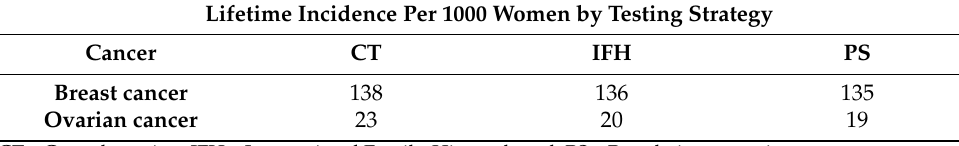
Table 3. Lifetime rates of cancer in different testing strategies.